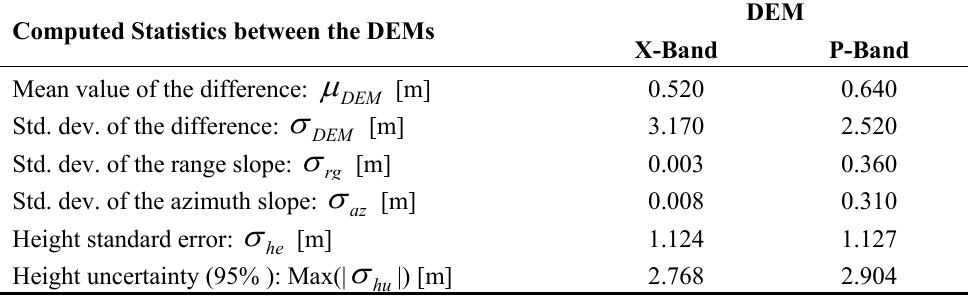
Table 6. Computed statistics between the DEMs in the intersection areas of all